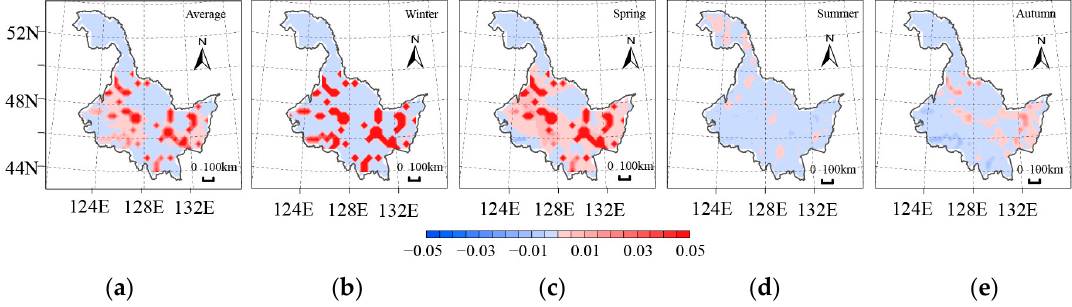
Figure 9. Maps to show the spatial distribution of surface albedo changes caused by the conversion of forests to cropland. ( a ) Annual average; ( b )Winter; ( c ) Spring; ( d ) Summer; ( e ) Autumn.